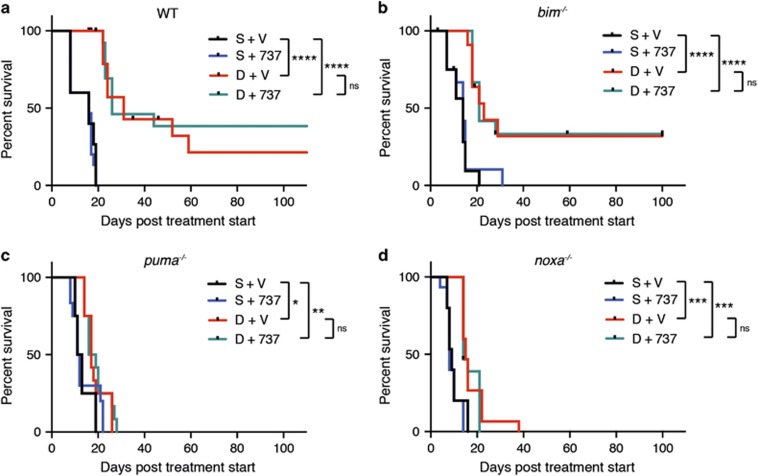
In vivo treatment of MLL-AF9 AMLs with daunorubicin in combination with ABT-737. Kaplan–Meier survival curves for mice transplanted with MLL-AF9 AMLs. 8–10-week-old Ly5.1 C57BL/6 mice (non-irradiated) were injected with 0.5 × 106 bone marrow cells from sick secondary WT/MLL-AF9 or BH3-only gene KO/MLL-AF9 mice (three recipients per tumor per treatment arm) and treatment was started 3 days later: 5 mg/kg daunorubicin [D] intravenously on days 1, 4 and 9 and/or 75 mg/kg ABT-737 [737] intraperitoneally on days 1–5 and 8–12; controls received saline [S] and ABT-737 vehicle [V]. Transplanted mice were monitored daily for symptoms of AML and euthanized if morbidly ill or at the end of experiment (100 days post treatment start). A total of (a) 5 WT/MLL-AF9 AMLs (#1211, 1223, 1224, 1411 and 1414), (b) 4 bim−/−
MLL-AF9 AMLs (#1158, 1213, 1249 and 1250), (c) 4 puma−/−
MLL-AF9 AMLs (#1218, 1225, 1226 and 1229) and (d) 5 noxa−/−
MLL-AF9 AMLs (#1306,1308, 1309, 1310 and 1311) were tested (see also Supplementary Figure S8 for individual tumor results). Statistical significance was determined by Log-rank (Mantle-Cox) test. *P<0.05, **P<0.01, ***P<0.001, ****P<0.0001. Daunorubicin treatment alone, or in combination with ABT-737, significantly prolonged survival of WT/MLL-AF9 and bim−/−/MLL-AF9 AMLs compared with saline treatment (P<0.0001), puma−/−/MLL-AF9 had significantly prolonged survival when treated with daunorubicin alone (P=0.0173) or with daunorubicin in combination with ABT-737 (P=0.0026), as did noxa−/−/MLL-AF9 when treated with daunorubicin alone (P=0.0006) or in combination with ABT-737 (P=0.0001). For all genotypes there was no significant difference (P>0.5) in survival between daunorubicin treatment and treatment with the combination of daunorubicin and ABT-737